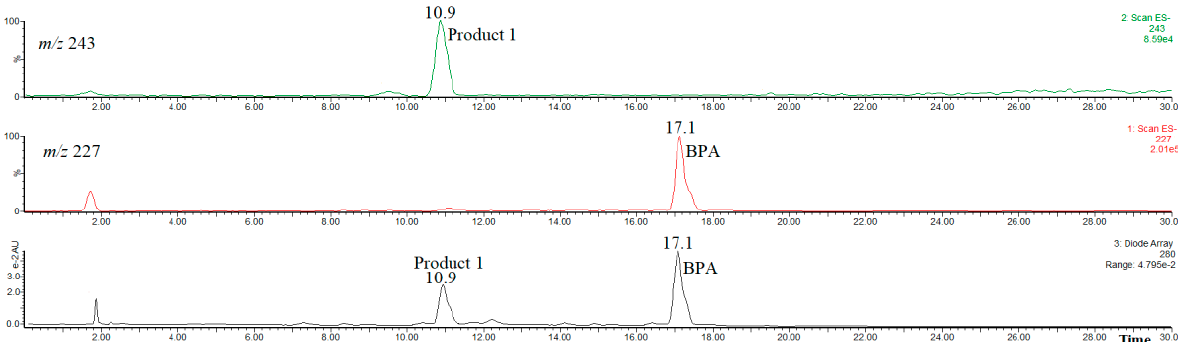
Figure 3. Exemplary HPLC/UV chromatograms obtained at 280 nm and single ion chromatograms of ions at m/z 227 and 243 ([M-H] − of BPA and Product 1, respectively) obtained using non-acidified gradient (Niepruszewo lake, summer, 45th day).